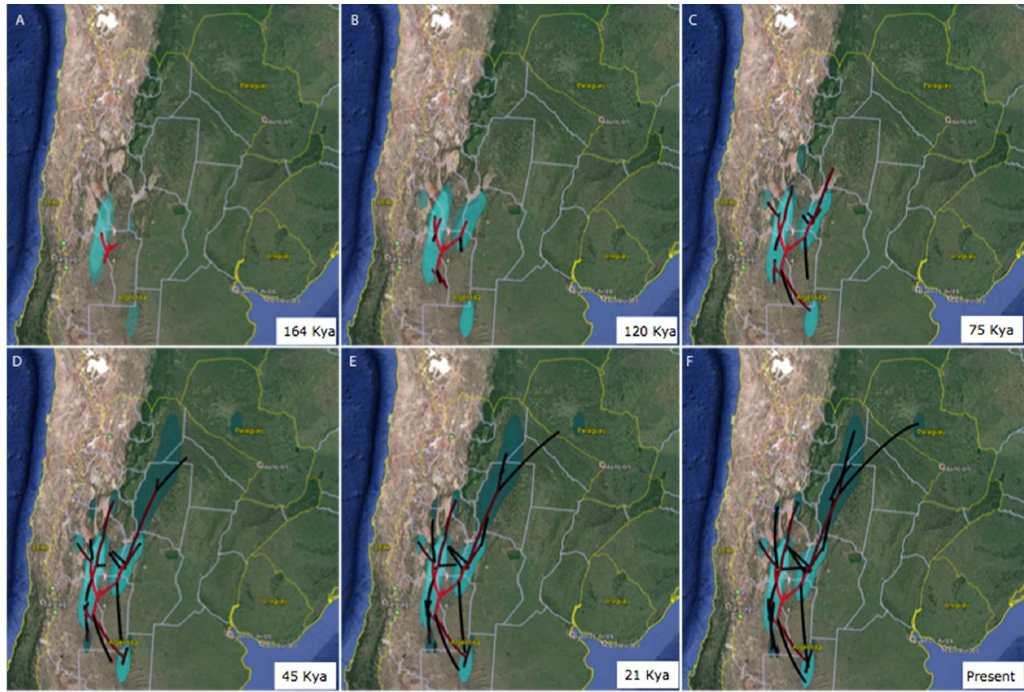
Figure 6. Reconstructed spatio-temporal diffusion of H. hydnorae in South America, shown at six time slices: ( A ) 164 kya . ( B ) 120 kya . ( C ) 75 kya . ( D ) 45 kya . ( E ) 21 kya . ( F ) Present time. Lines represent branches of the maximum clade credibility tree (MCC), estimated with a Bayesian phylogeographic analysis in BEAST using a “Relaxed Random Walk” (RRW) model of continuous diffusion through time and space. Map data ©2018 Google Imagery ©2018 NASA, TerraMetrics.